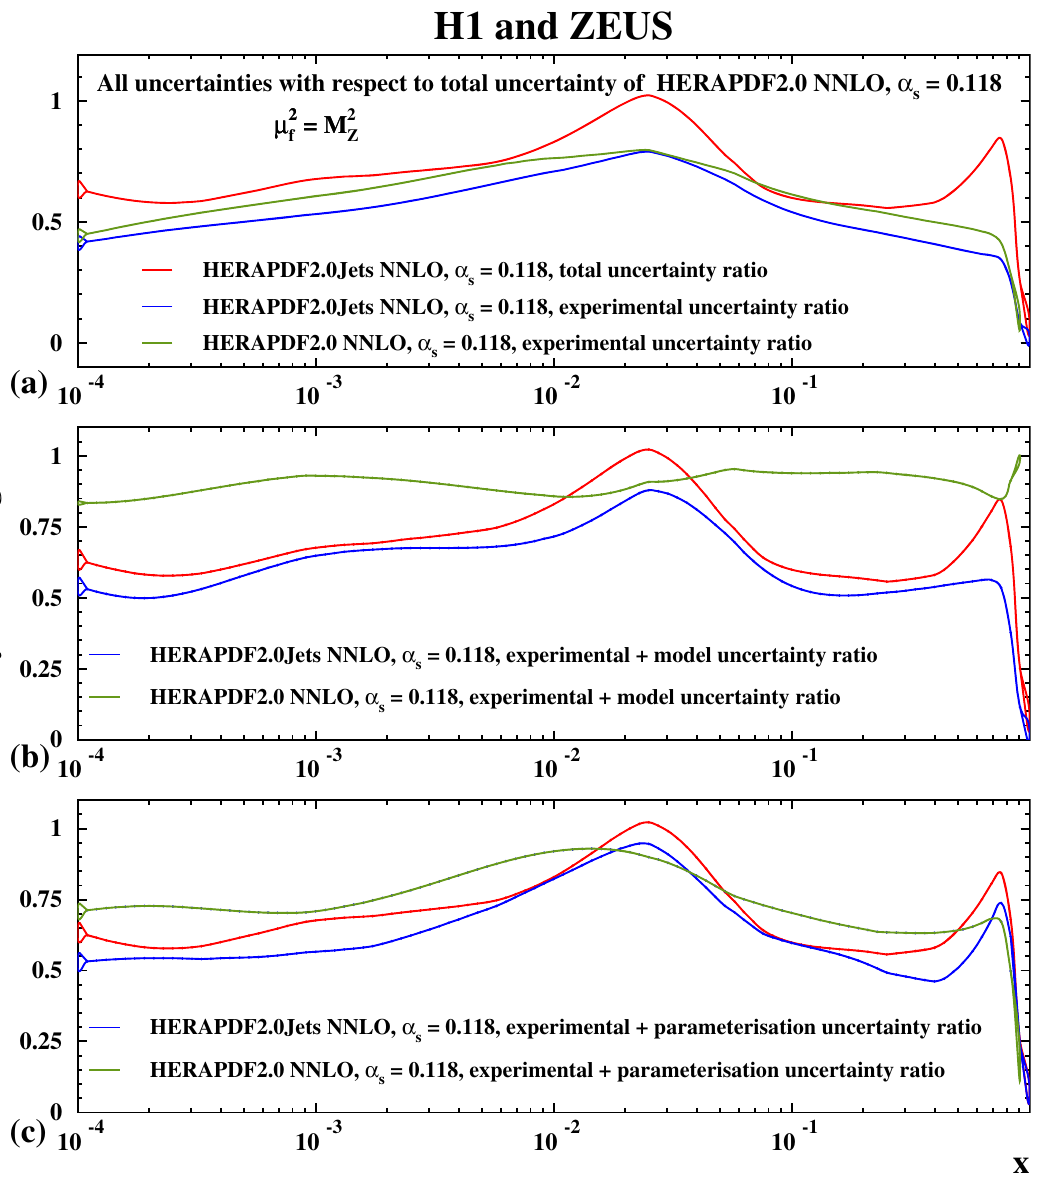
Fig. 24 Ratios of uncertainties relative to the total uncertainties of HERAPDF2.0NNLOwith α s ( M 2 HERAPDF2.0Jets NNLO with α s ( M 2